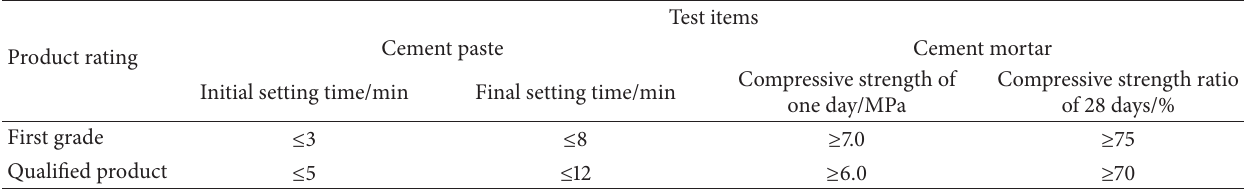
Table 2: Performance requirements of cement paste and cement mortar mixing accelerator.